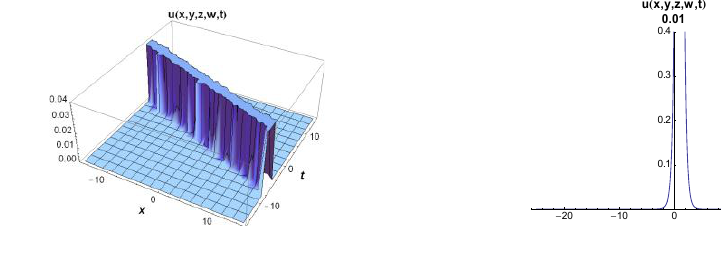
Fig.1. The 3D and 2D surfaces of Eq. (18) for